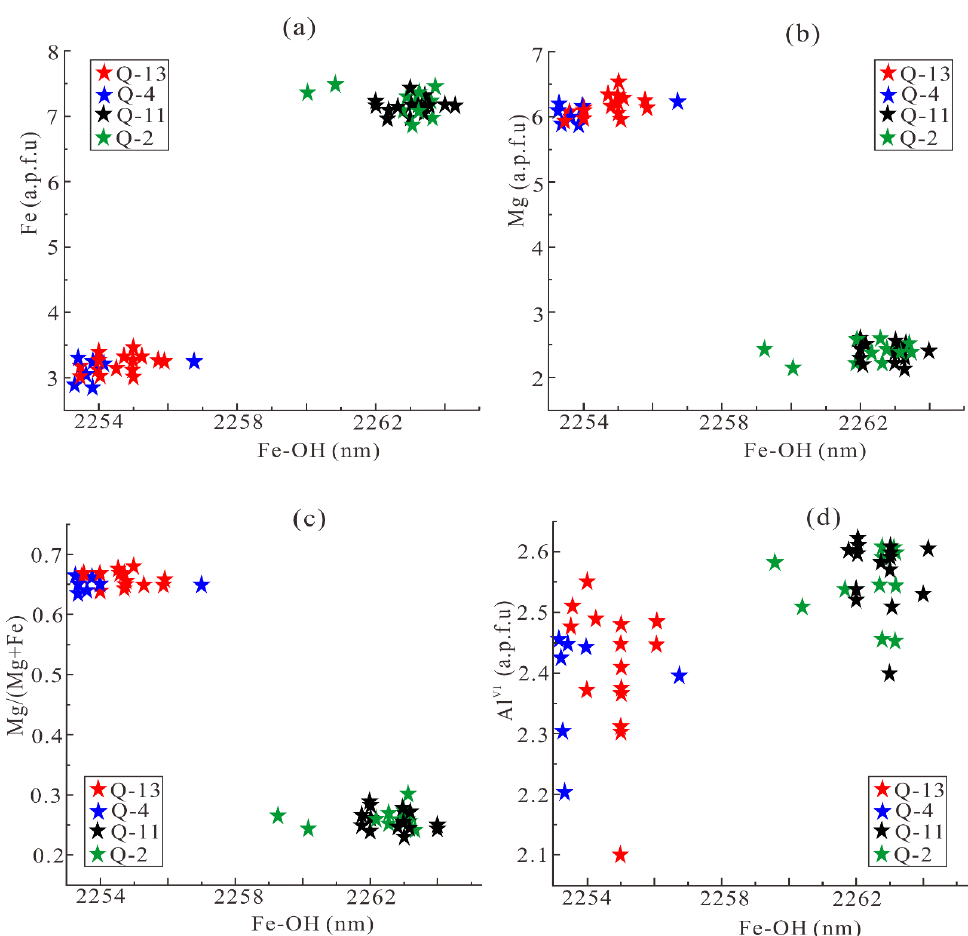
Figure 20. The relationship between the wavelength of Fe-OH band and the content of cations in the octahedral layer of chlorite: ( a ) the relationship between Fe-OH and Fe; ( b ) the relationship between Fe-OH and Mg; ( c ) the relationship between Fe-OH and Mg/(Mg+Fe); ( d ) the relationship between Fe-OH and Al VI (the overlap points have been offset for clarity).